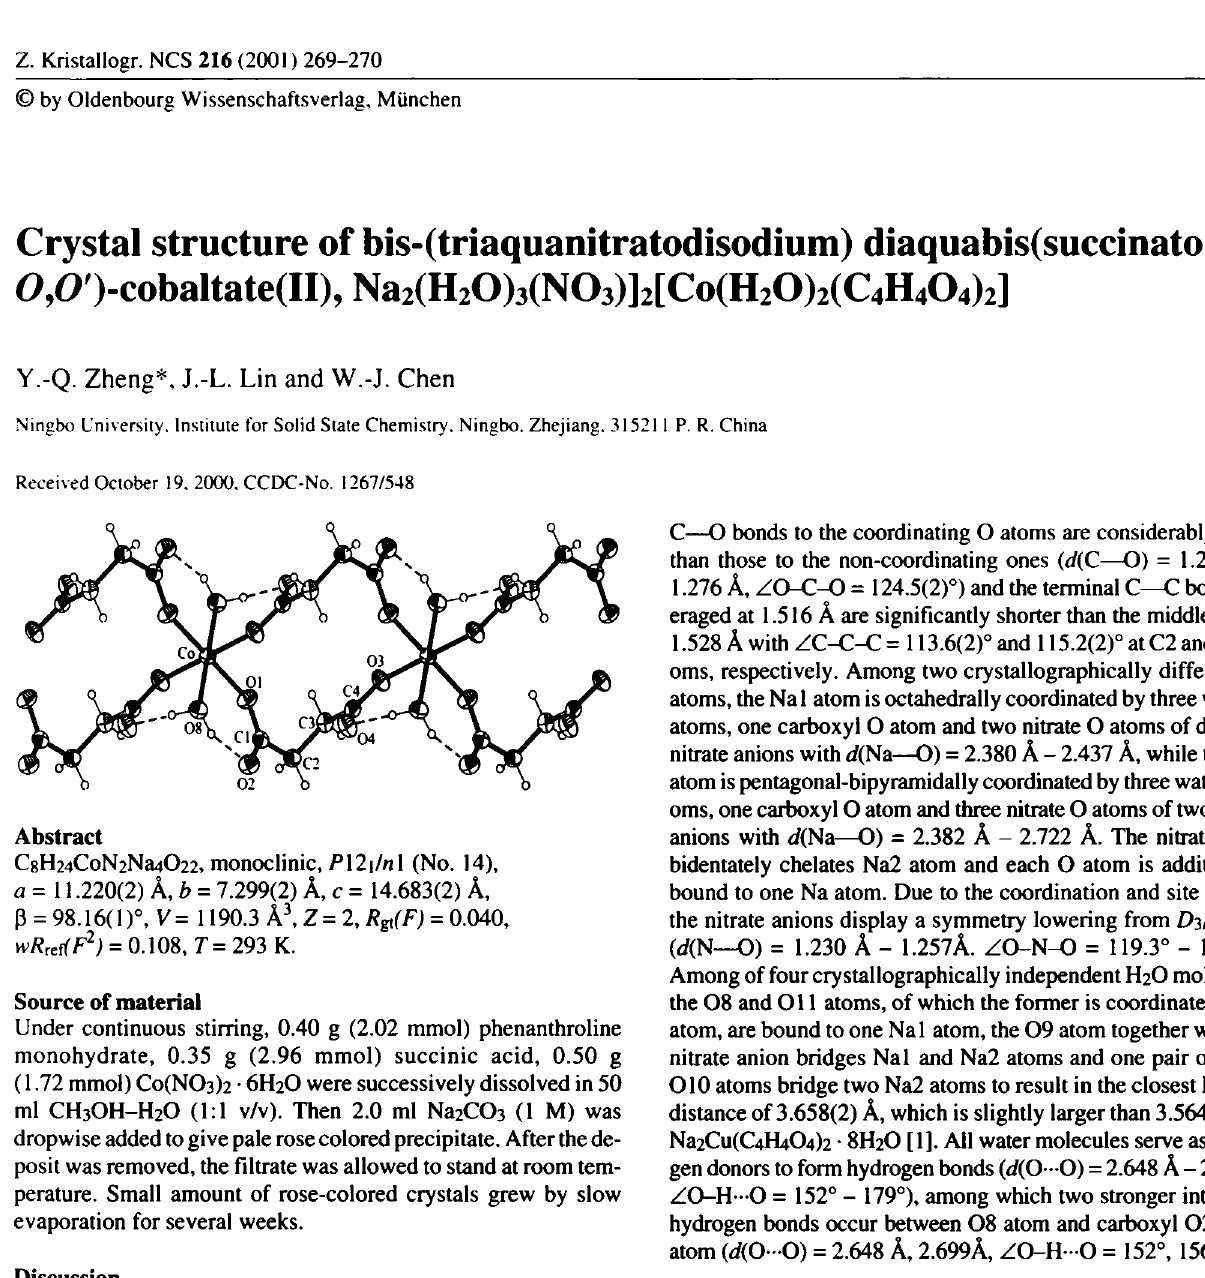
Table 1. Data collection and